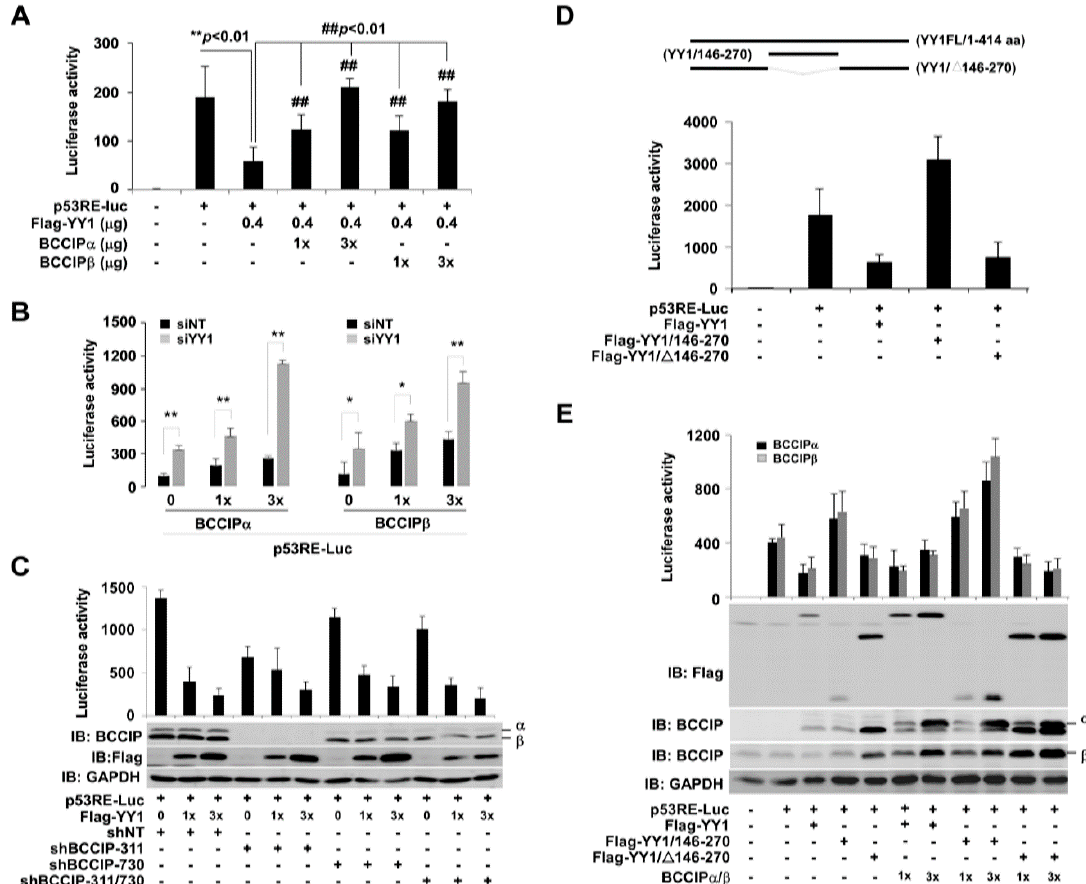
Figure 5. YY1 and BCCIP co-regulated the p53RE-mediated luciferase activity in HCT116 (p53+/+) cells. ( A ) Effects of BCCIP on p53RE-Luc activity in the Flag-YY1 transfected cells. Experiments were performed with the indicated design. ** p < 0.01, t -test, comparison to empty vector-transfected group, while ## p < 0.01, t -test, comparison to Flag-YY1-transfected group. ( B ) Effects of BCCIP on p53RE-Luc activity in the YY1 knockdown cells. Experiments were performed with the indicated design. ** p < 0.01, t -test, comparison to empty vector-transfected group. ( C ) Effect of YY1 on p53RE-Luc activity in the BCCIP knockdown cell. Experiments were performed with the indicated design. ( D ) Impact of deletion mutants of YY1 on p53RE-Luc activity. The upper panel shows a schematic diagram of deletion mutants of YY1. p53RE-Luc luciferase activities were measured after co-transfection of p53RE-Luc and deletion mutants of YY1 (48 h) ( n = 3). ** p < 0.01, t -test, comparison to p53RE-Luc-transfected group. ( E ) Coordinative roles of BCCIP and YY1 on p53RE-Luc activity. Experiments were performed with the indicated design.